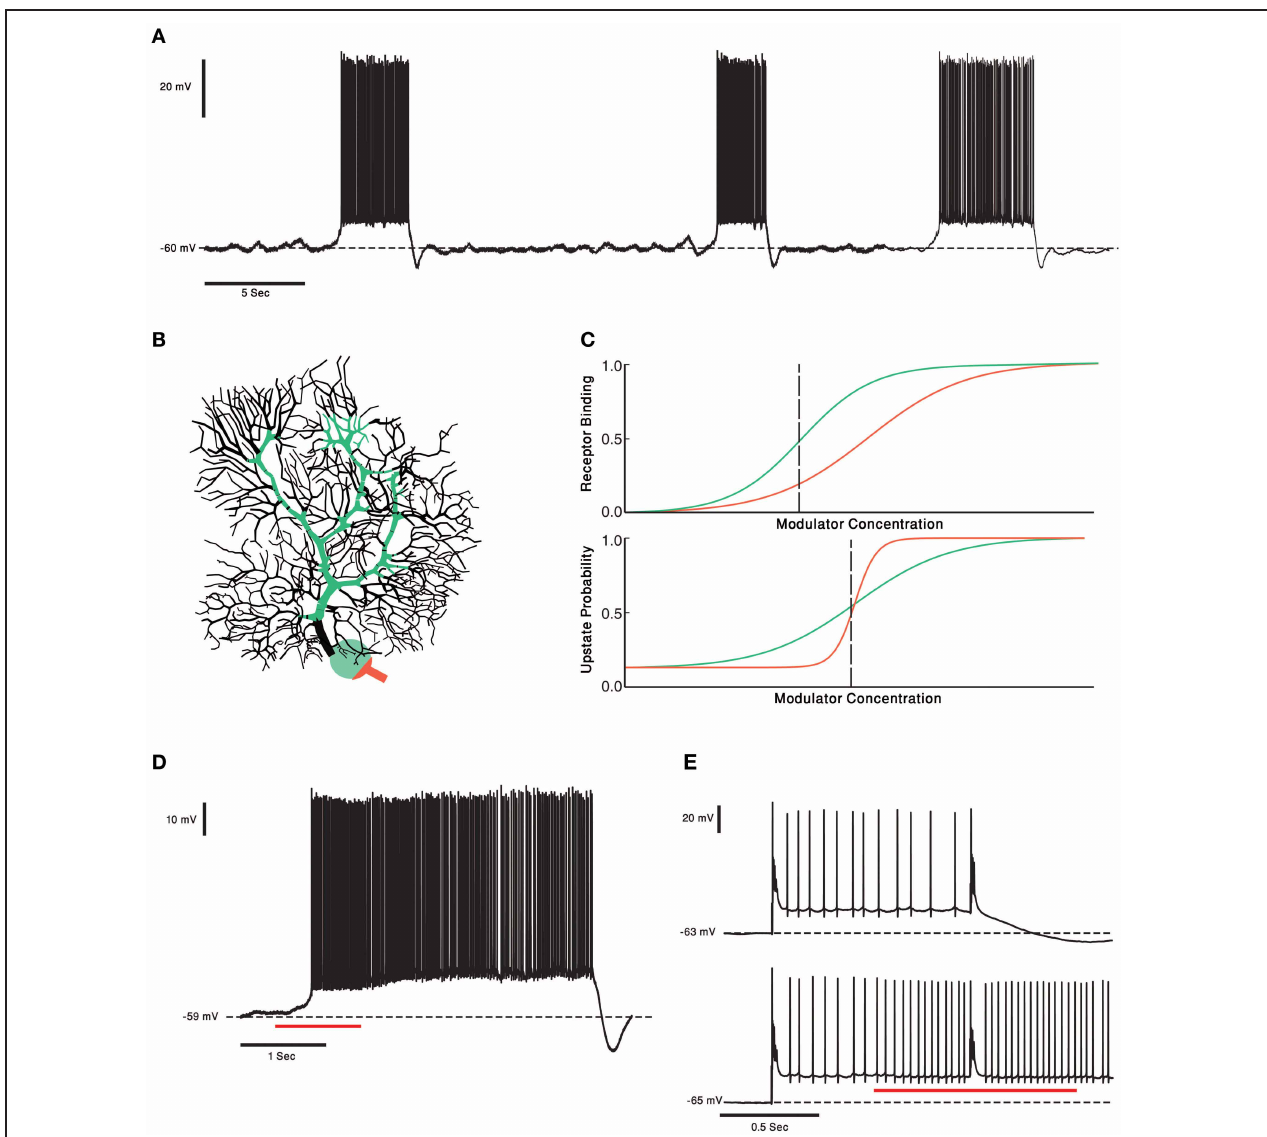
FIGURE 4 | PCs and two Receptors modulation. (A) Voltage trace from in vitro recording of a PC. The PC two states of membrane voltage, the “up” and “down” state are visible. (B) Schematic representation of the two receptor model. In this case the receptor with high affinity (green) is localized to soma and proximal dendrite and the Low affinity receptor (orange) is localized to the axon hillock and initial segment. This compart- mental distribution resembles the distribution of CRF receptors in PCs. (C) Schematic plot of the two receptor’s affinities (upper panel). Activation of the receptors changes the PCs probability to be in an “up” state. The relationship between the neuromodulator concentration and the probability